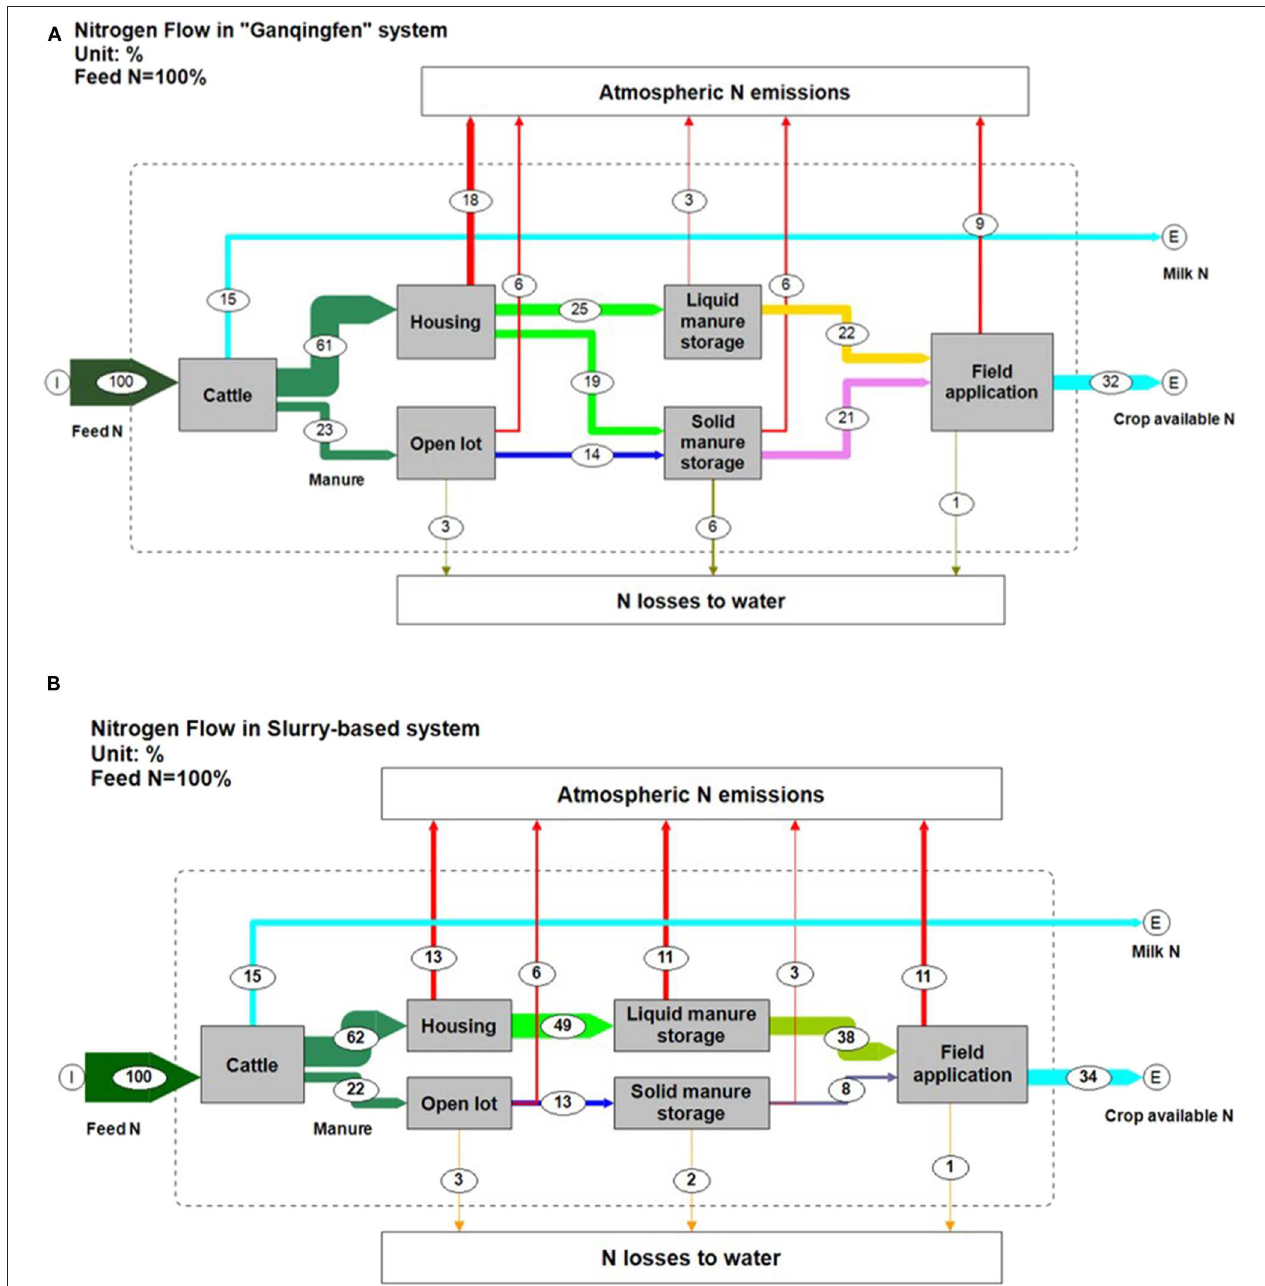
FIGURE 2 | Characteristics of N flow in manure management chain of two typical dairy farms. (A) N flow in “Ganqingfen” system. (B) N flow in slurry-based